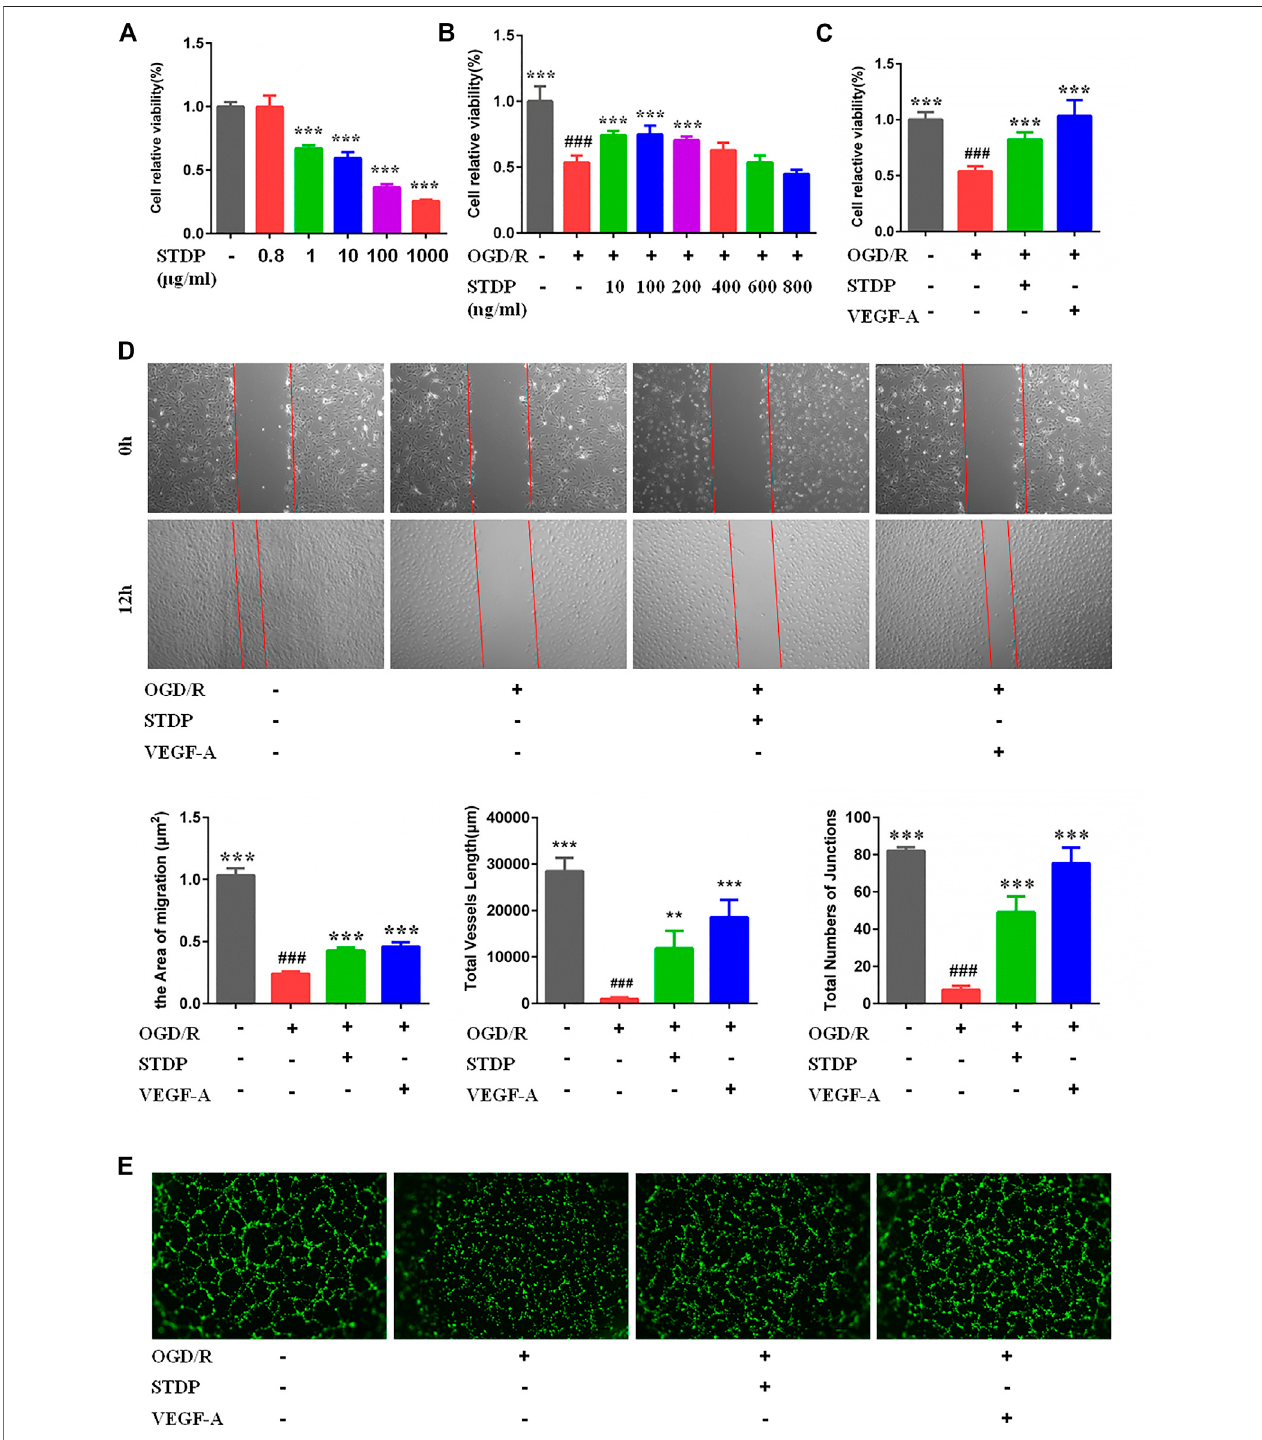
FIGURE4| STDPsenhancedtheproliferation,migration,andtube-formingcapacityofHUVECs. (A) STDPs(800 ng/ml)havenocytotoxicityonHUVECs. (B) Bone marrow-derived macrophages (BMDMs) were treated with various concentrations of STDPs for 24 h (C) STDPs (100 ng/ml) promoted the cell viability in OGD/ R-induced HUVECs. VEGF-A (20 ng/ml) promoted the proliferation capacity of HUVECs. N = 6 per group. (D) STDPs promoted cell migration in OGD/R-induced HUVECs. N = 3 per group. (E) STDPs promoted tube formation in OGD/R-induced HUVECs. N = 3 per group. VEGF-A was used as the positive control. ** p < 0.01, *** p < 0.001 vs . the model group; # # # p < 0.001 vs . the sham group.